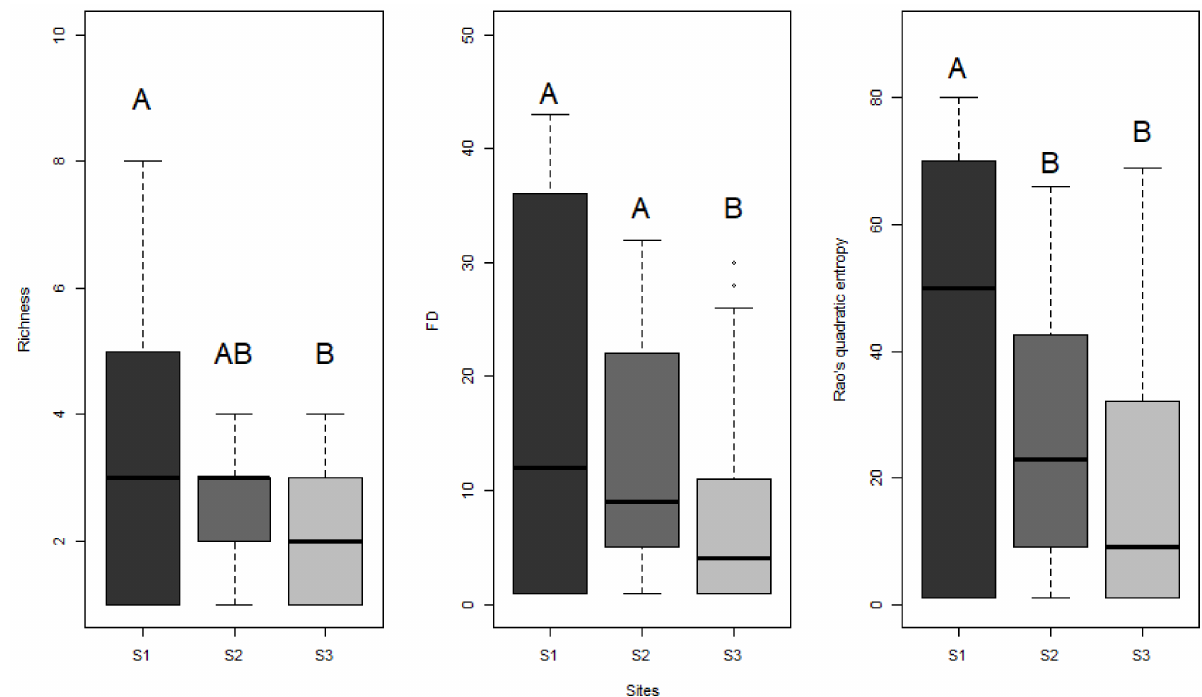
Figure 5. Boxplot of diversity metrics (species richness, functional richness (FD), and Rao’s quadratic entropy) compared between the three sites along a north-south gradient (S1 being in the south and S3 in the north). Significant differences ( p < 0.05) are represented using different successive letters (e.g., A &